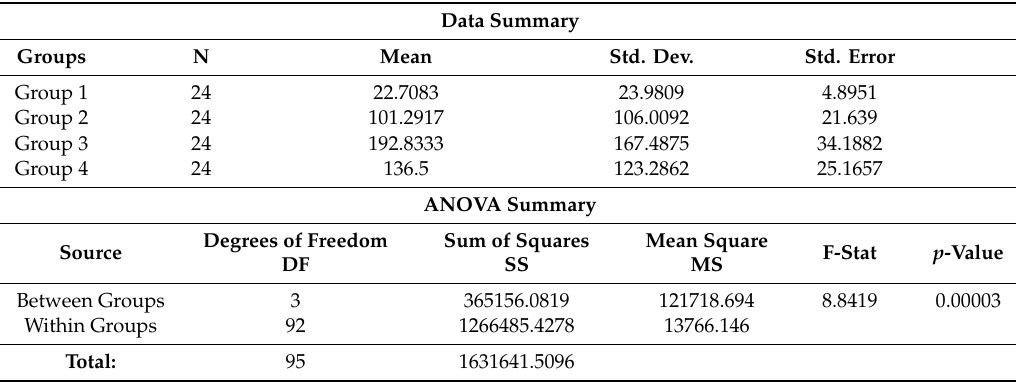
Table 5. Results of the ANOVA analysis for breaking force.